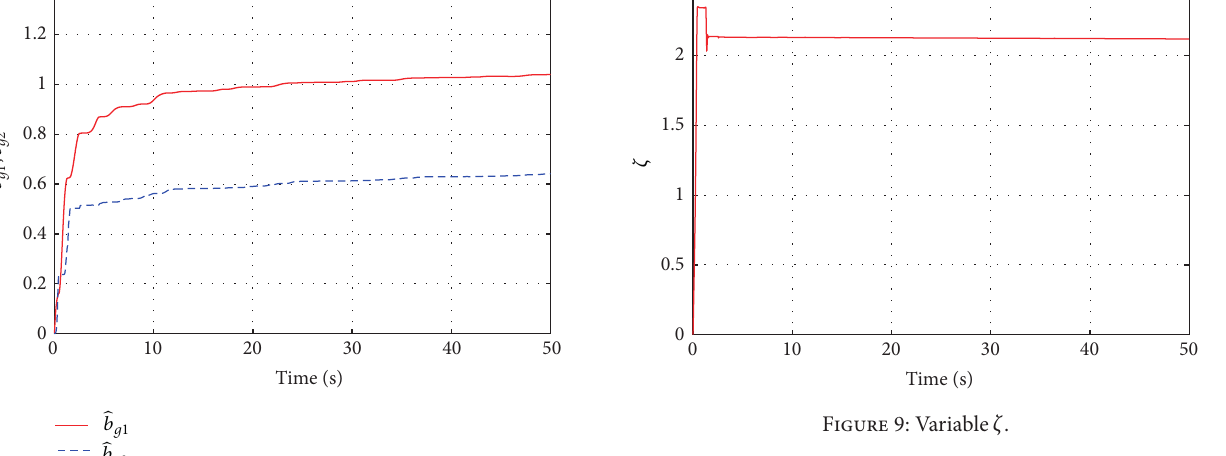
̂𝑏 𝑔 2 (dashed line).